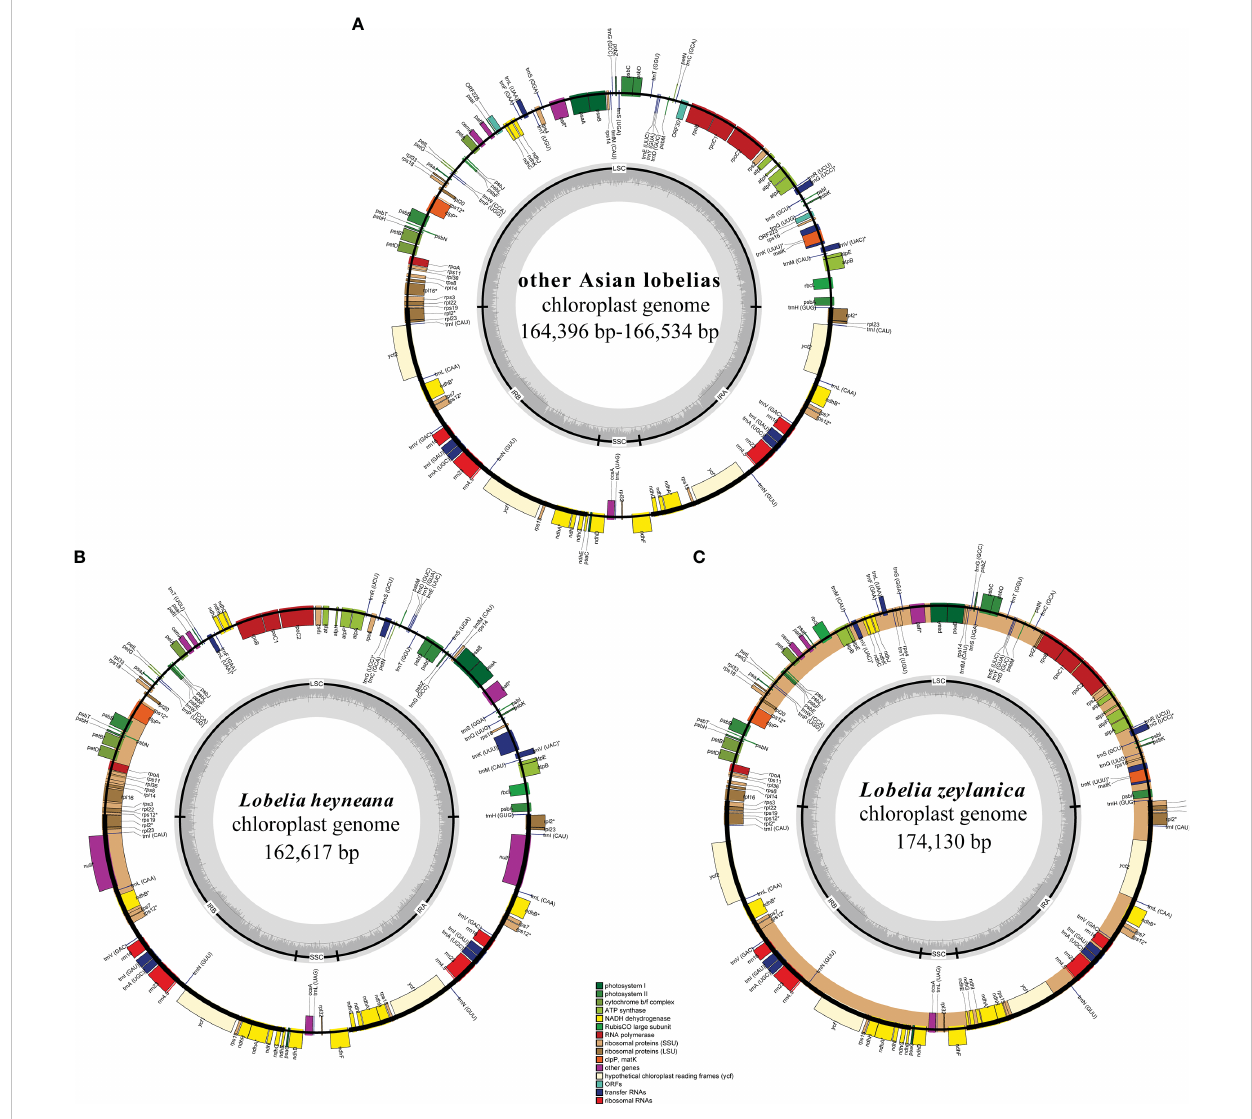
FIGURE 1 Plastid genomes of other East Asian lobelias (A) , Lobelia heyneana (B) , and Lobelia zeylanica (C) . Genes inside the circle are transcribed clockwise, and genes outside the circle are transcribed counter-clockwise. The dark-gray inner circle corresponds to the GC content, and the light-gray represents the AT